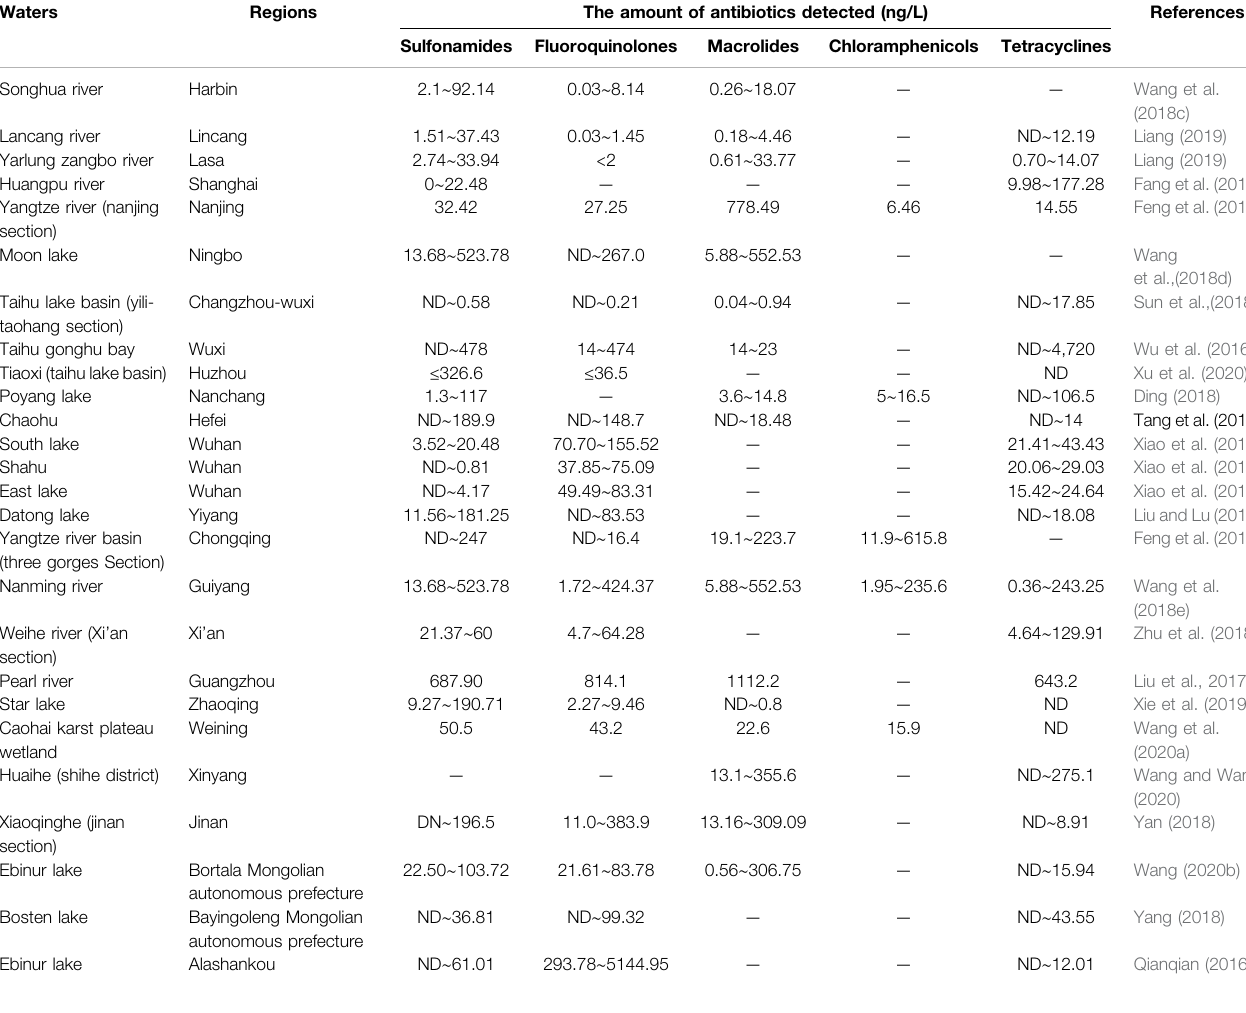
TABLE 2 | Distribution of antibiotics in different waters of China (From 2015 to